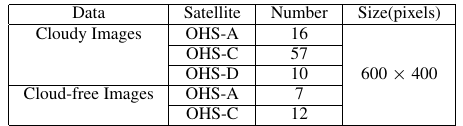
Table 1. Information about experiment data. We did not use data of OHS-B because we did not get data from it.